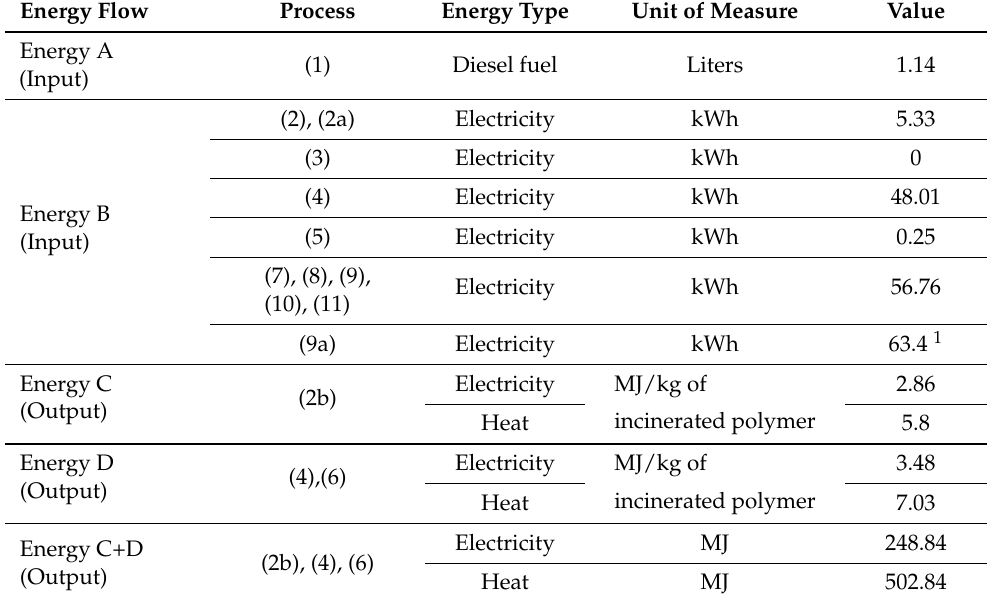
Table 2. Energy flows of the considered system.